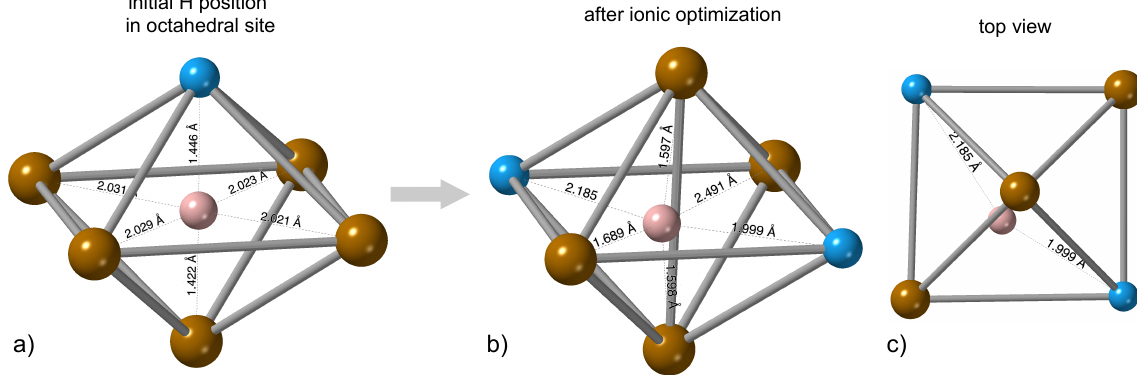
Figure 4. The relaxation (i.e, an energy minimization with respect to) H position from the octahedral site with one Al atom ( a ) into a neighboring octahedral environment with two Al atoms where the H atom moves away from an ideal symmetric octahedral position into a tetrahedral-like site ( b ) that is shown also from another view-angle as a top-view in sub-figure ( c ).